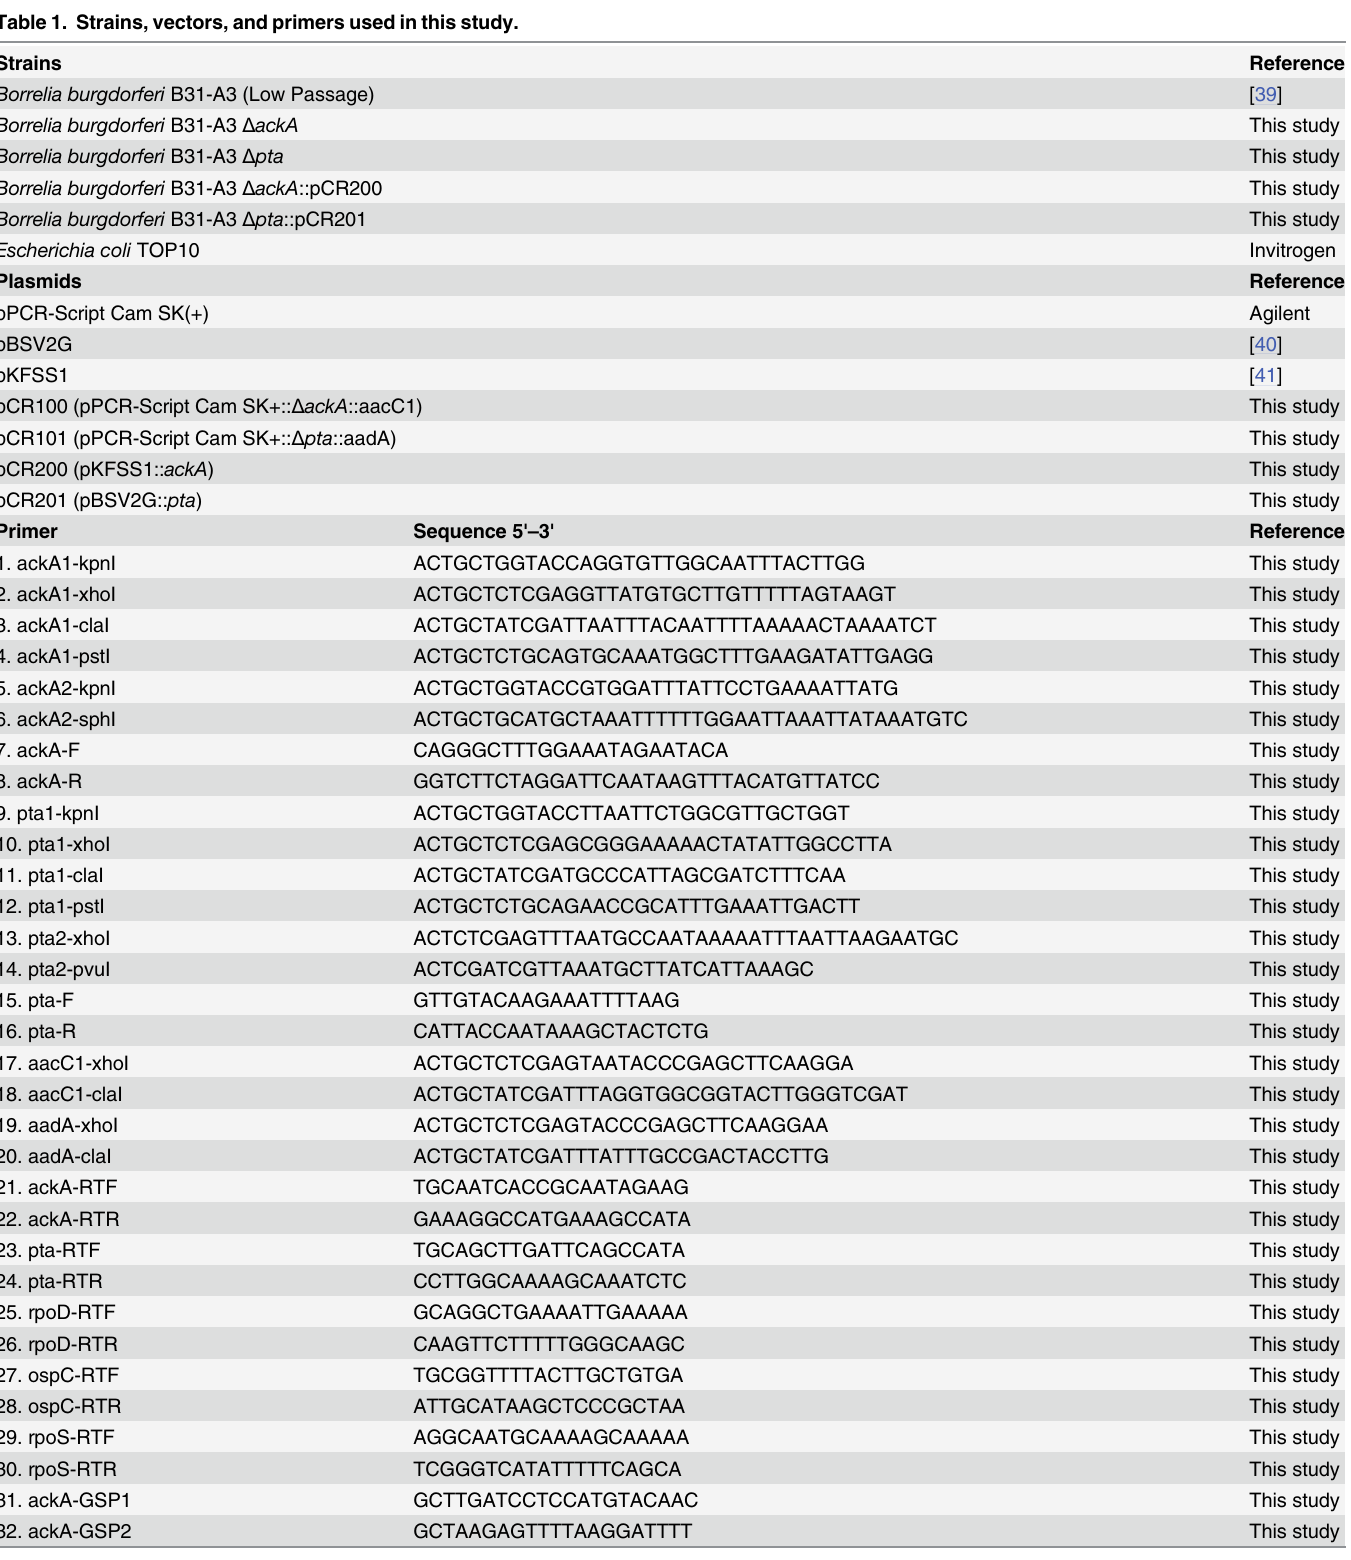
Table 1. Strains, vectors, and primers used in this study.